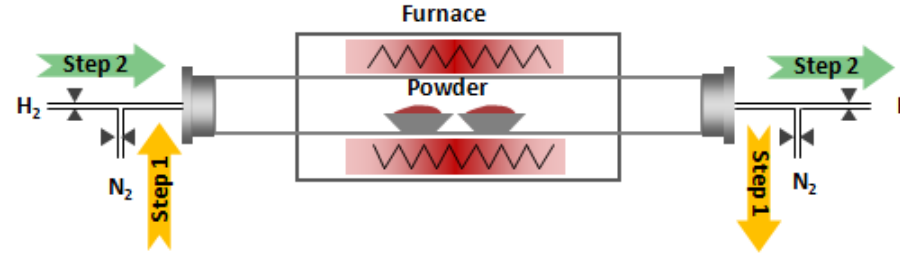
Figure 2. Schematic diagram of reduction device.